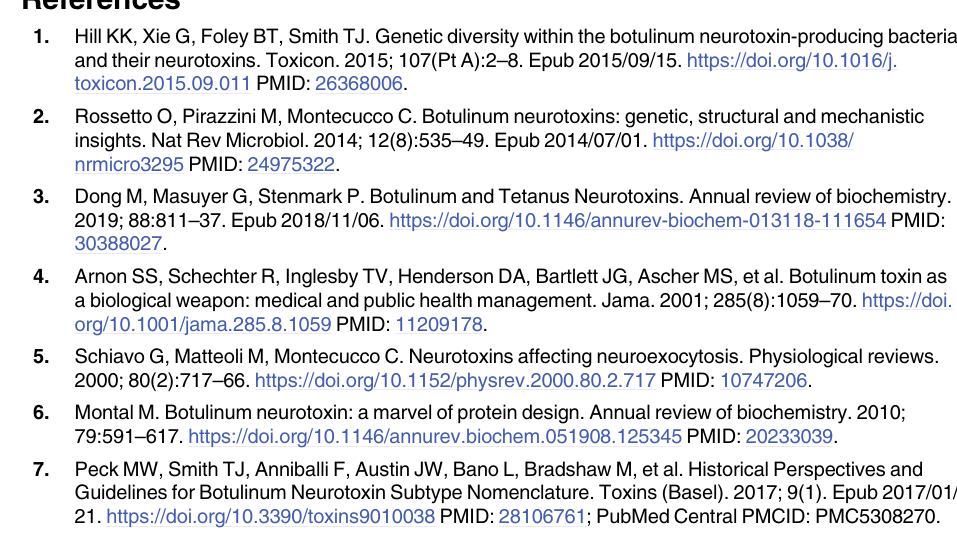
S1 Raw Images. Raw gel images of western blotting or Coomassie blue staining data included in Figs 3F, 5A, S1A and